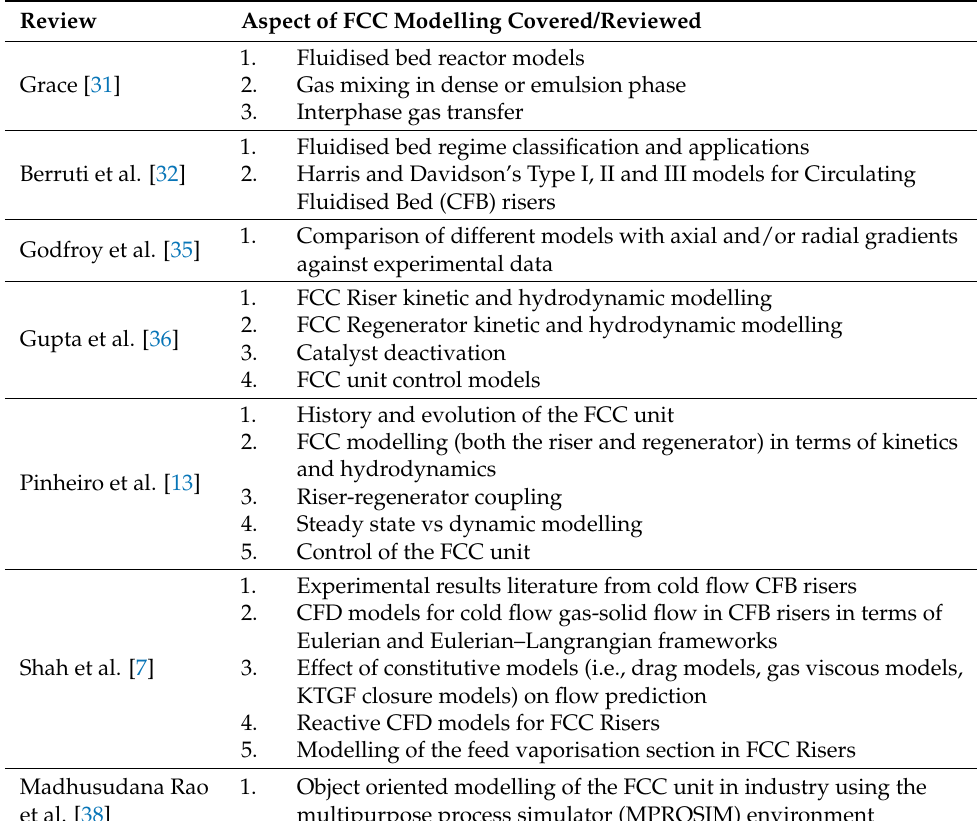
Table 2. Summary of previous reviews in the literature relevant to FCC